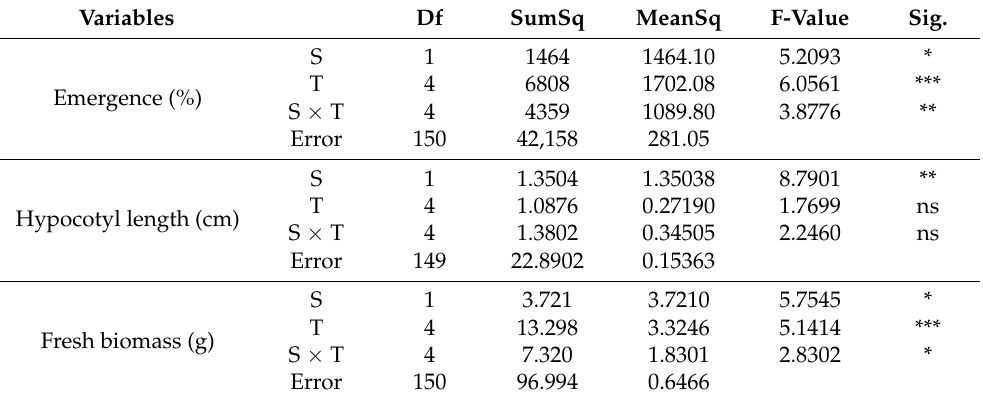
Table 2. Analysis of variance of hormones and nitrogen fertilizers treatments on the emergence, hypocotyl, and fresh biomass of A. artemisiifolia seedlings. Variables